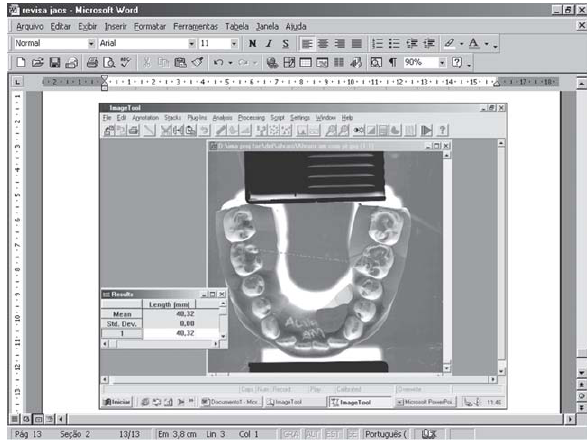
FIGURE 2- Measurement of the intermolar distance in the ImageTool ®